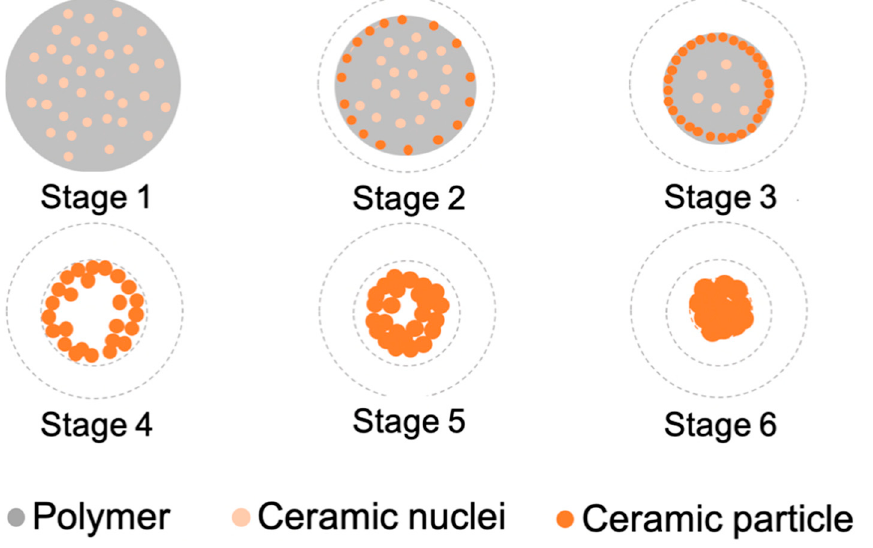
Figure 10. Overall fiber transformation mechanism .